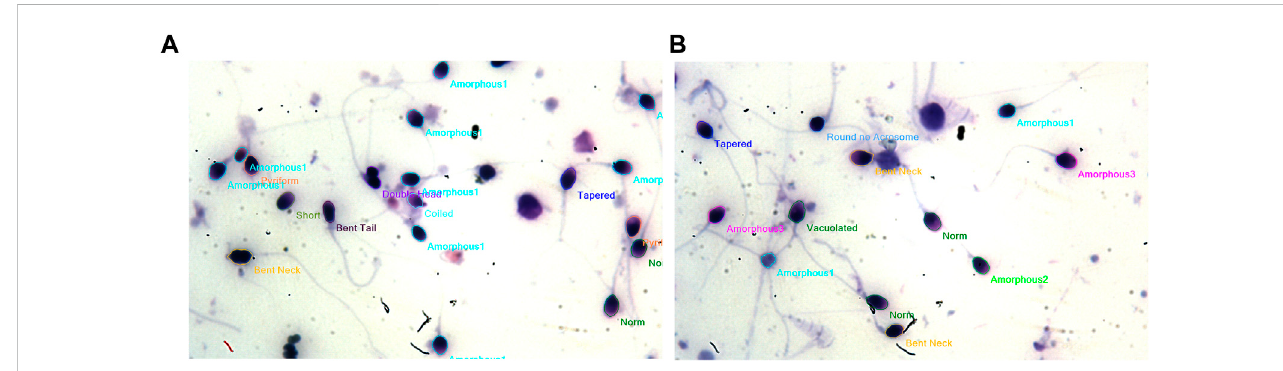
FIGURE 4 (A,B) :Imageshowingmorphologicalcharacterizationfortheeffectof100 μ g/mlAMLEonspermcellsshowingmoreamorphousandbentneckcellsare observed after